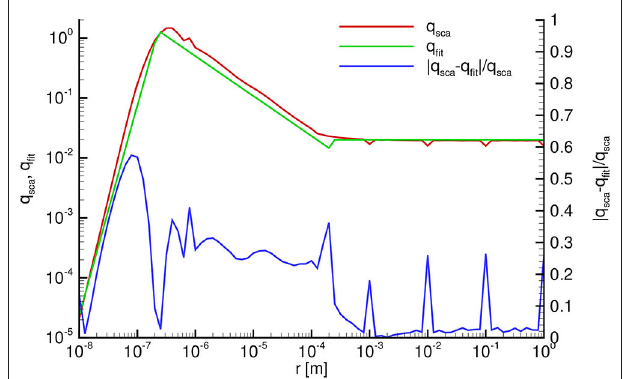
FIGURE 3 | Scattering efficiency as a function of dust radius: computed (comp, red) according to section 2.4, and fitted (fit, green). The relative difference between the computed and fitted is shown in blue.